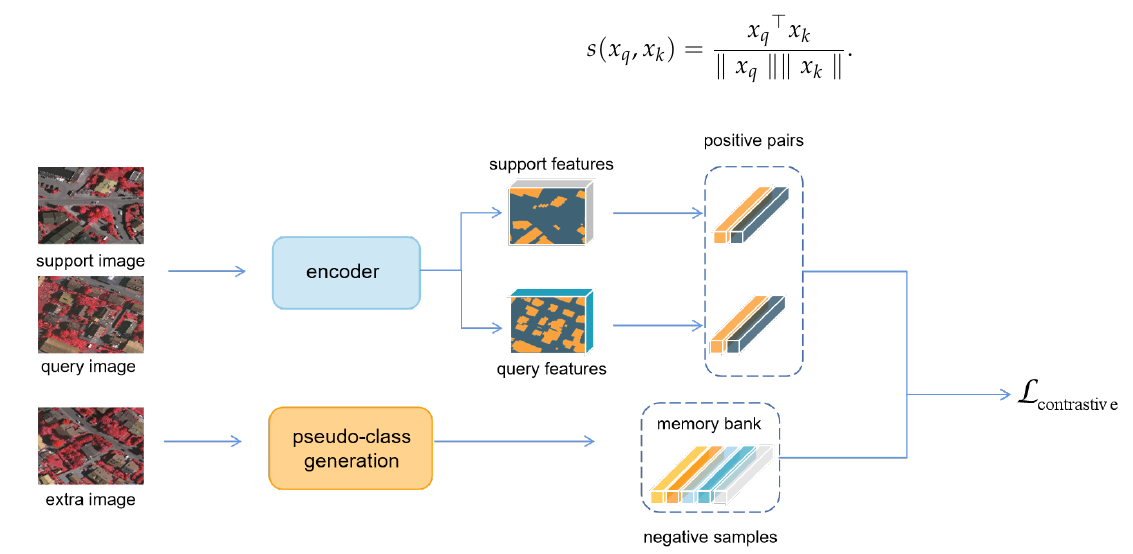
Figure 3. Detailed diagram of contrastive representation learning that learns general features between categories by computing distance between target classes and latent classes.